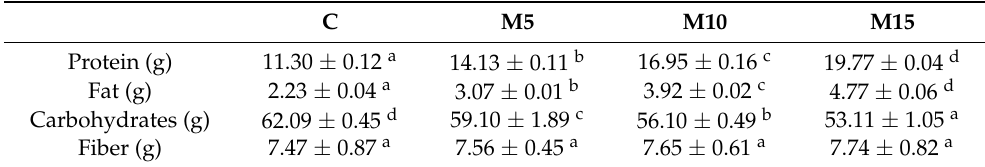
Table 4. Composition of bread produced with wheat flour and mealworm